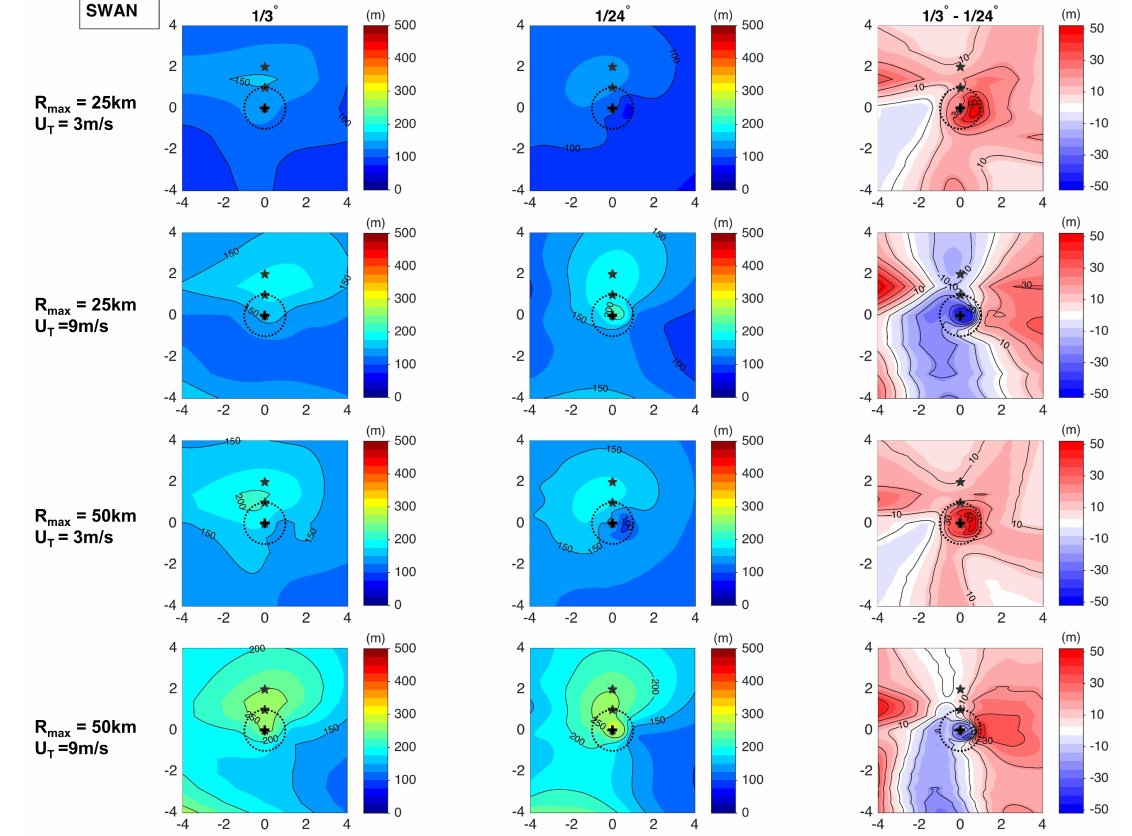
Figure 10. Spatial distribution of wavelength corresponding to mean wavenumber (wavenumber weighted averaged by spectral density) in time-averaged quasi-steady state wave fields from